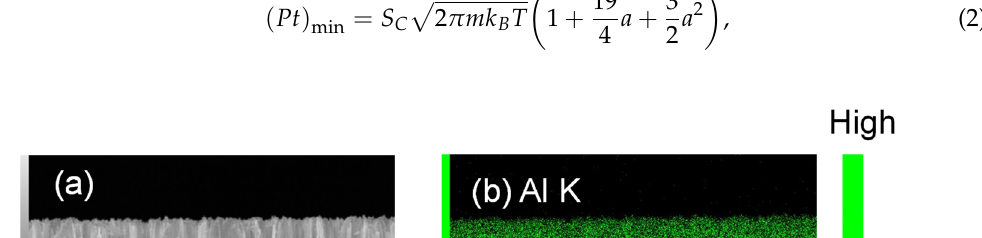
4.4 × 10 4 Langmuir (1 Langmuir = 1.33 × 10 − 4 Pa·s = 1.0 × 10 − 6 Torr·s), respectively. Accord-